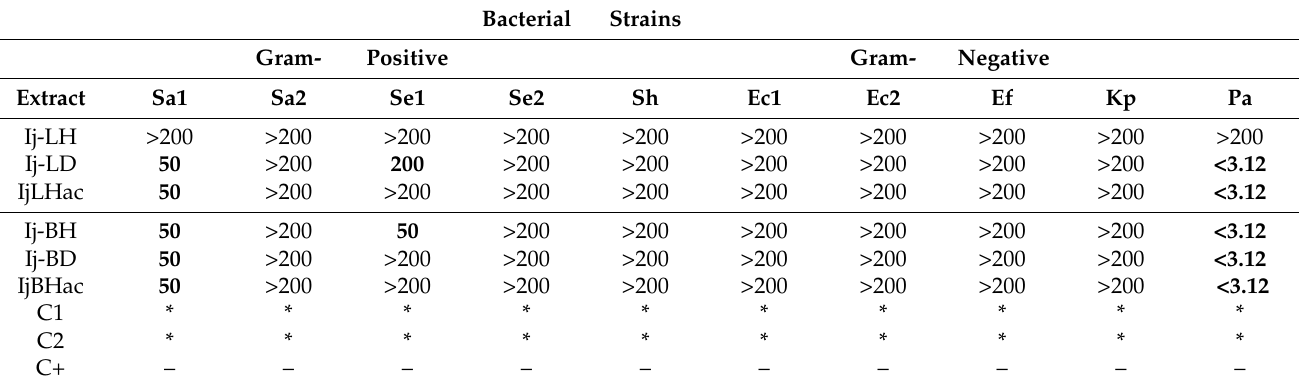
Table 4. Antibacterial activity (MIC µ g/mL) of extracts from Inga jinicuil .